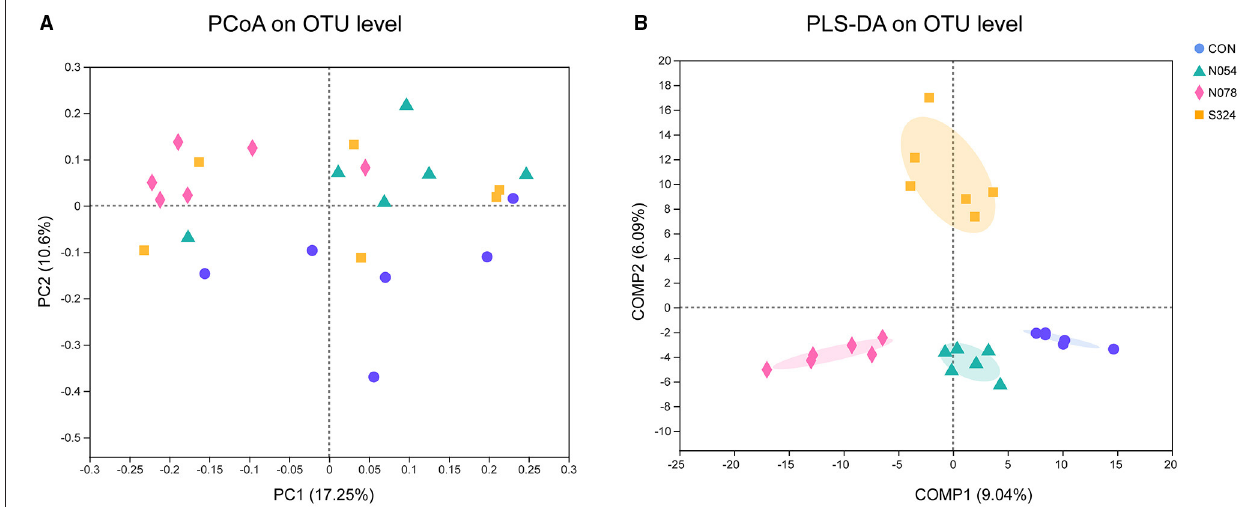
FIGURE 1 | Beta diversity analysis in four groups with unsupervised and classification methods. (A) Principal coordinates analysis (PCoA). Bray–Curtis distances and permutational multivariate analysis of variance (PERMANOVA) were performed. p = 0.001 and p adjust = 0.001. (B) Partial least squares discriminant analysis (PLS-DA). Each sample was represented by a dot ( n = 6). CON, control group; N054, 0.54mM sucralose; N078, 0.78mM sucralose; S324, 324mM